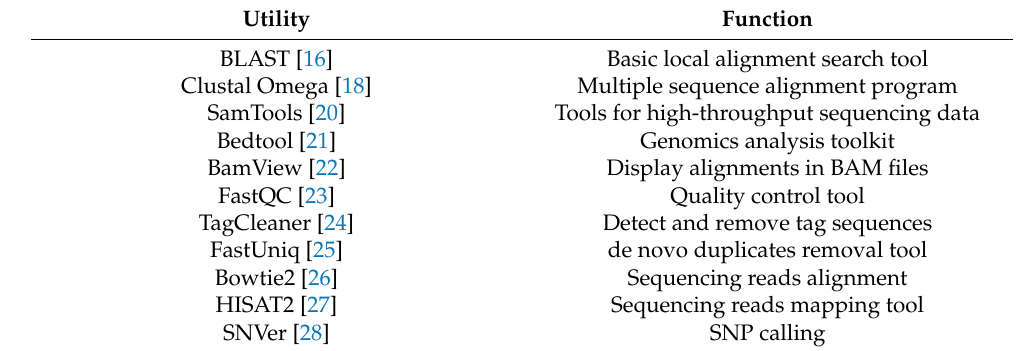
Table 2. Some commonly used utilities bundled in the peripheral